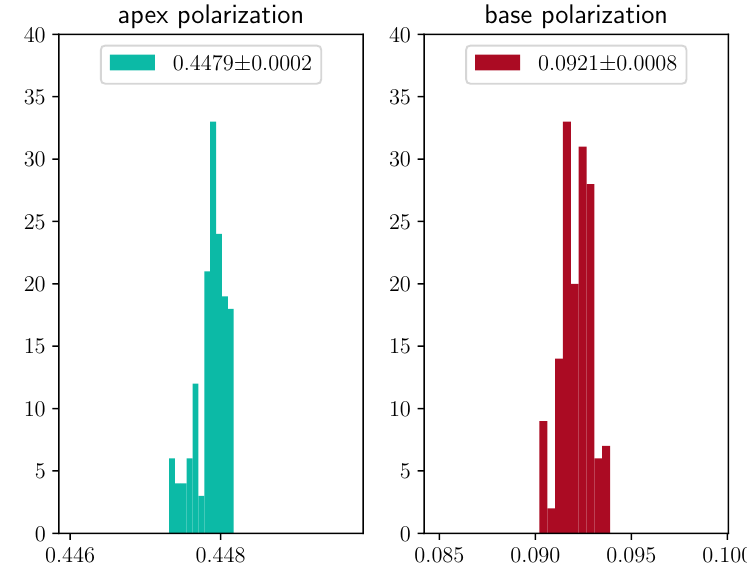
(cid:10) (cid:11) (cid:10) (cid:11) S A S B (apex) and (base) for i i